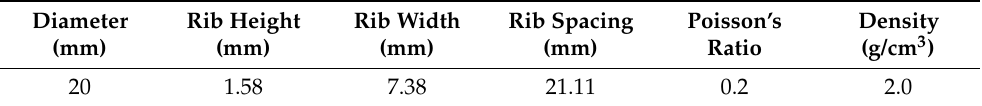
Table 1. Parameters of GFRP bars.